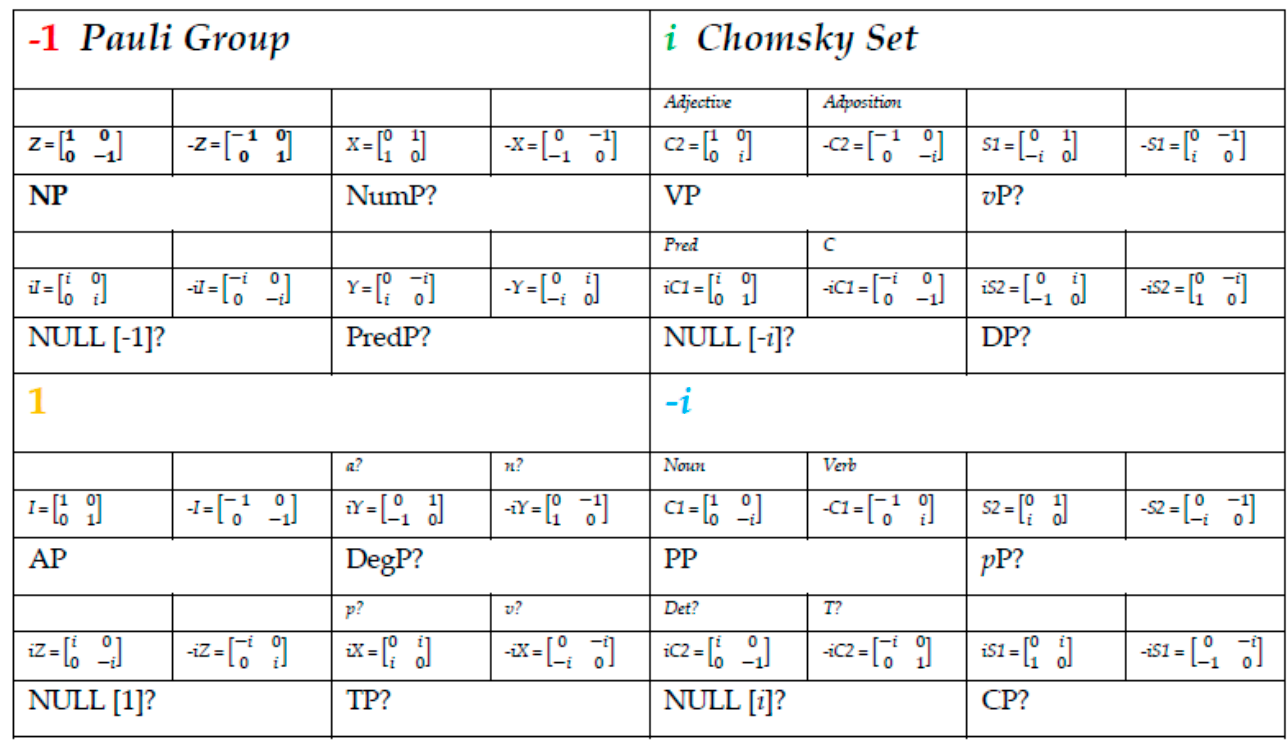
Figure 3. “Periodic Table” of syntactic categories based on the G CP